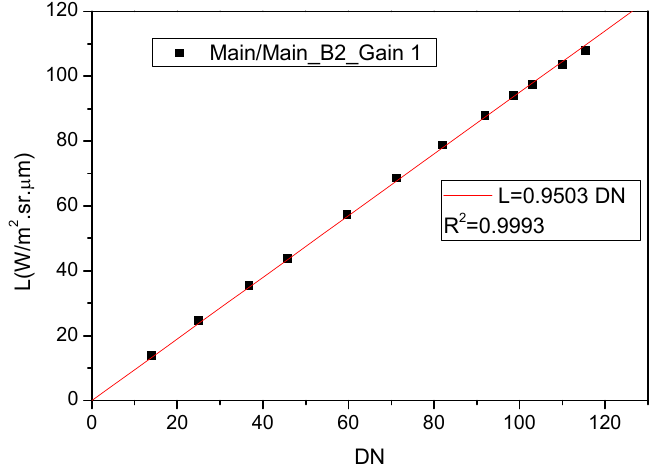
Figure 5. Example of the absolute calibration coefficient determination for main-main sub- system combination, CCD2 and gain